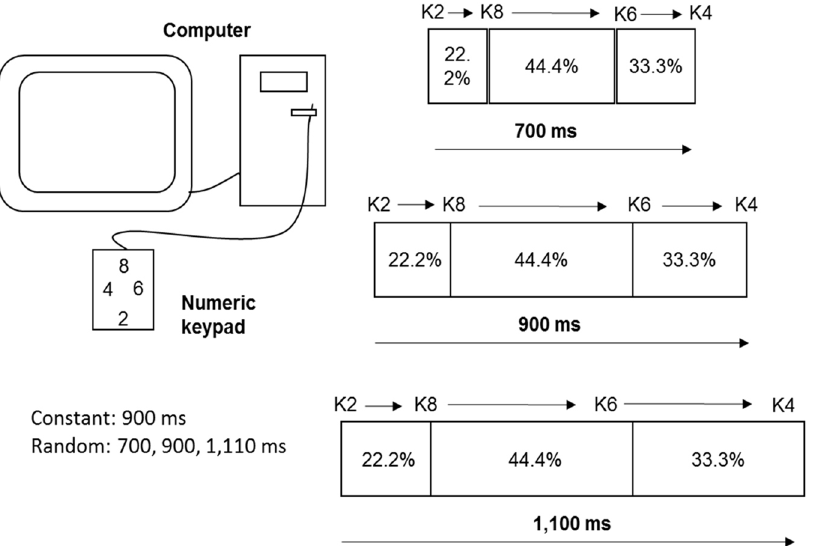
Figure 8. Apparatus used to apply the motor task, the sequence of keys typed (K2 … K8), the relative criterion segment ratios between keys (22.2%, 44.4%, and 33.3%) and the total criterion movement times (700, 900, and 1,100